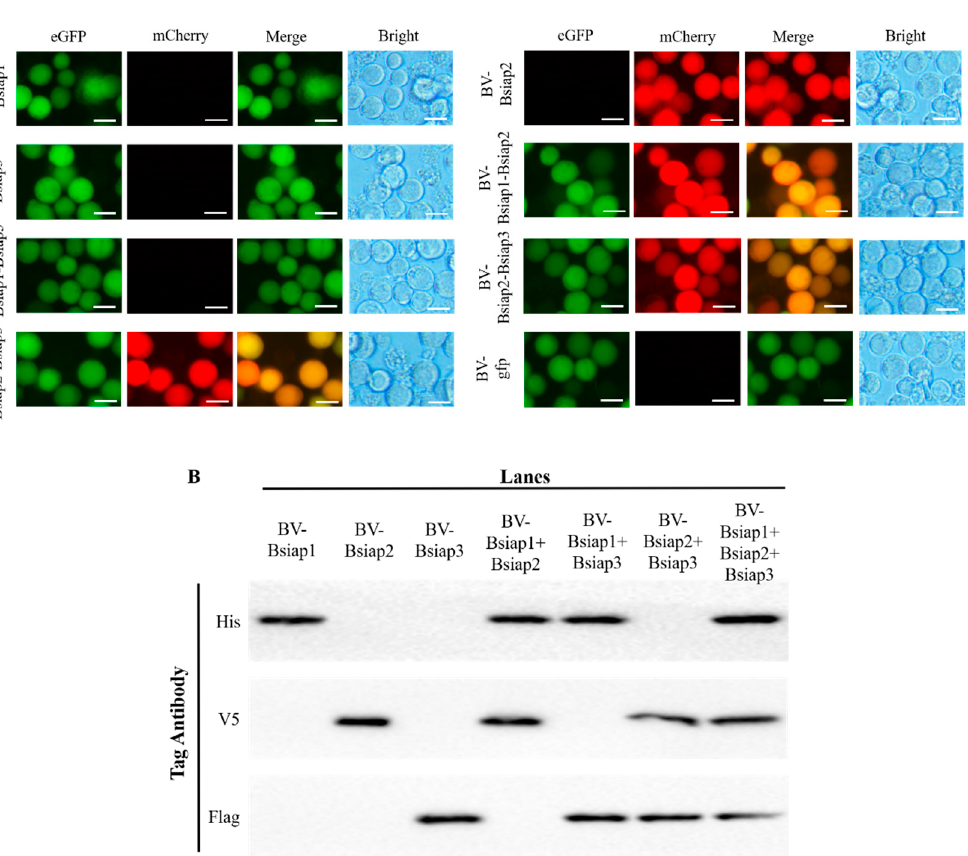
Figure 6. Construction of recombinant baculovirus and identification of BsIAPs. ( A ) Expression of eGFP and mCherry were observed by fluorescence microscopy, indicating that the seven recombinant baculoviruses successfully infected Sf9 cells (Bar, 25 μ m). Control cells were infected with BV-gfp under the same operation. ( B ) Western blot analysis using the three anti-tag antibodies (His, V5, and Flag) showed that BsIAPs were highly expressed after 72 h of Sf9 cell infection with the seven recombinant baculoviruses. The abscissa shows the cell samples infected by the seven groups of baculoviruses (BV) respectively. The ordinate indicates that different samples were identified by western blot using three tag antibodies. The result shows that different BsIAP proteins (or their combinations) are successfully and efficiently expressed in cells ( B ).